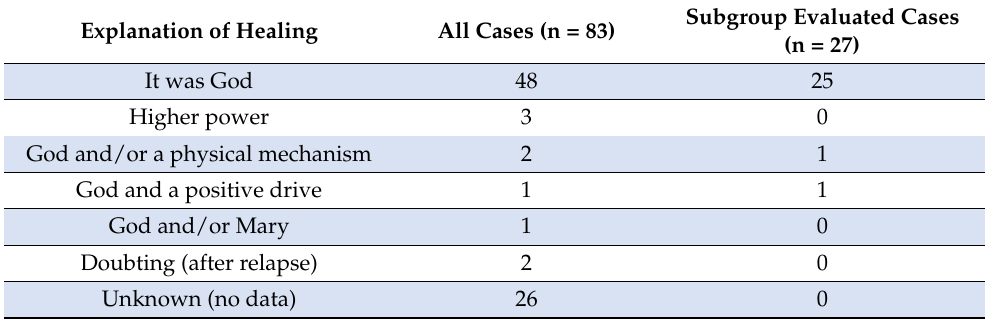
Table 13. Explanation of healing.